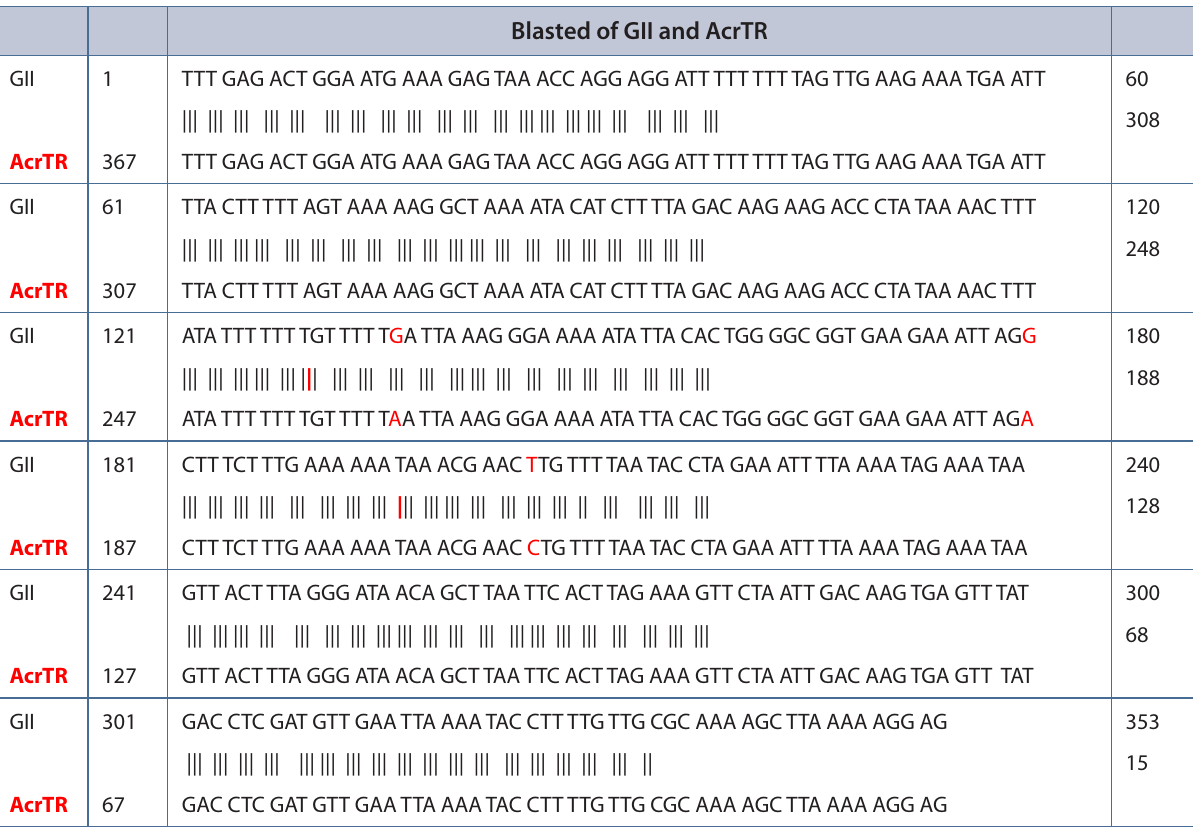
Table 4. Genetic group II (GII) was found to be 98.7% homologous with AcrTR (accession number AJ277598) Blasted of GII and